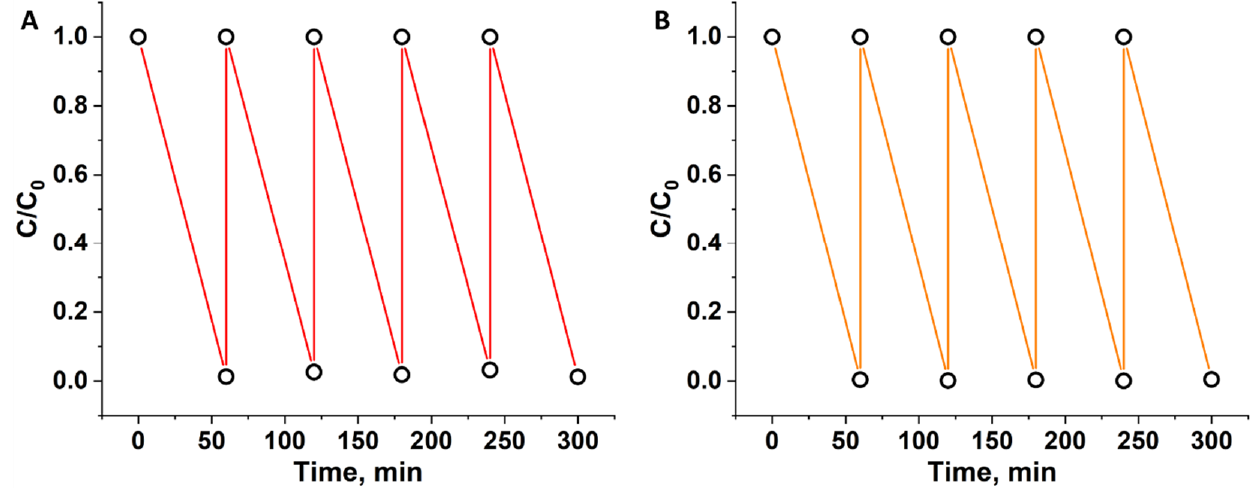
Figure 6. Cycling of 1 0.1 @TiO 2 ( A ) and 2 0.1 @TiO 2 ( B ) in RhB photocatalytic decomposition. Solar light. In addition, photocatalytic activity of pure TiO 2 and n 0.1 @TiO 2 was evaluated under direct sunlight irradiation. The experiments were performed as earlier, but without stirring in the middle of august under clear sky (T air ~ 25 °C). The complete decomposition of RhB in the presence of pure titania was achieved in 90 min with k eff of 0.036 min –1 (Figure 7). Similar to experiments under UV-light, both n 0.1 @TiO 2 demonstrated close activity decomposing RhB after ~45–50 min with k eff of 0.12 and 0.14 min –1 for n = 1 and 2 correspondingly. One can see, that all of the samples show some increase in the activity, which is due to the continuous spectrum of solar light providing more photons with a suitable wavelength.